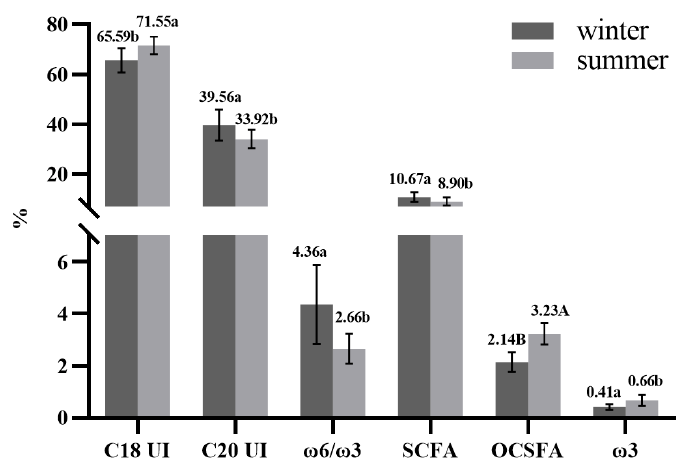
Figure 2. The fatty acid groups and lipid quality health indices have a significant difference in winter and summer of crossbred buffalo raw milk. a, b—values differ significantly between two groups ( p < 0.05), A, B—values differ extremely significantly between two groups ( p <